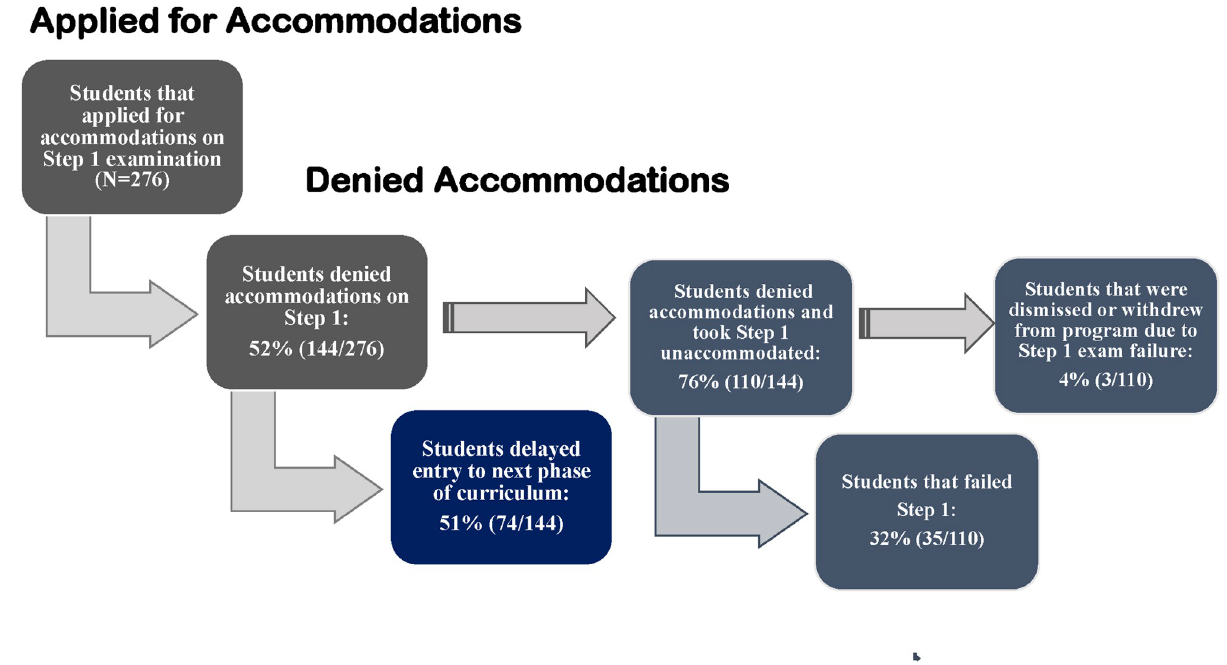
Fig 1. Progression of students with disabilities denied accommodations on Step 1 examination.